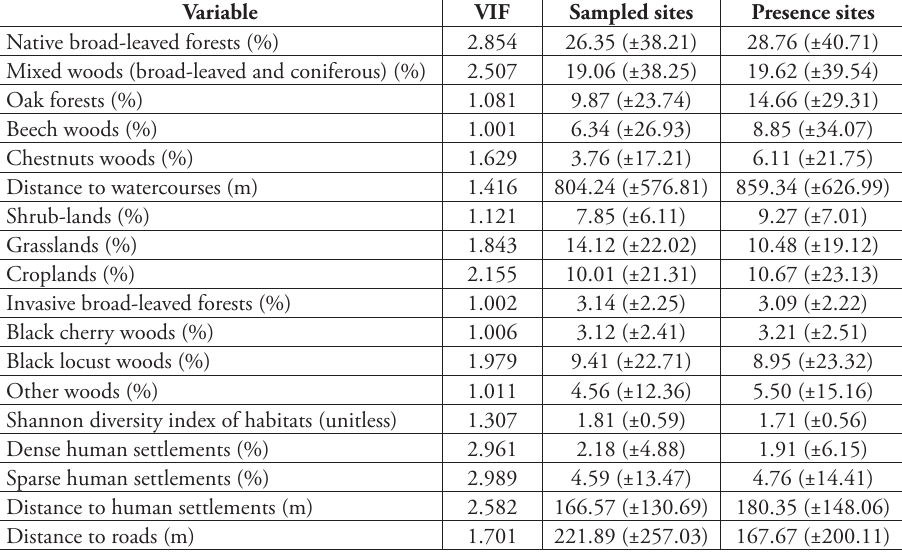
Table 1. Variables used in the development of stag beetle ( Lucanus cervus ) Ensemble of Small Models. Variables with Variance Inflation Factor (VIF) > 3 have to be removed due to multi-collinearity with other variables. Average values ± standard deviations at sampled and presence sites are also